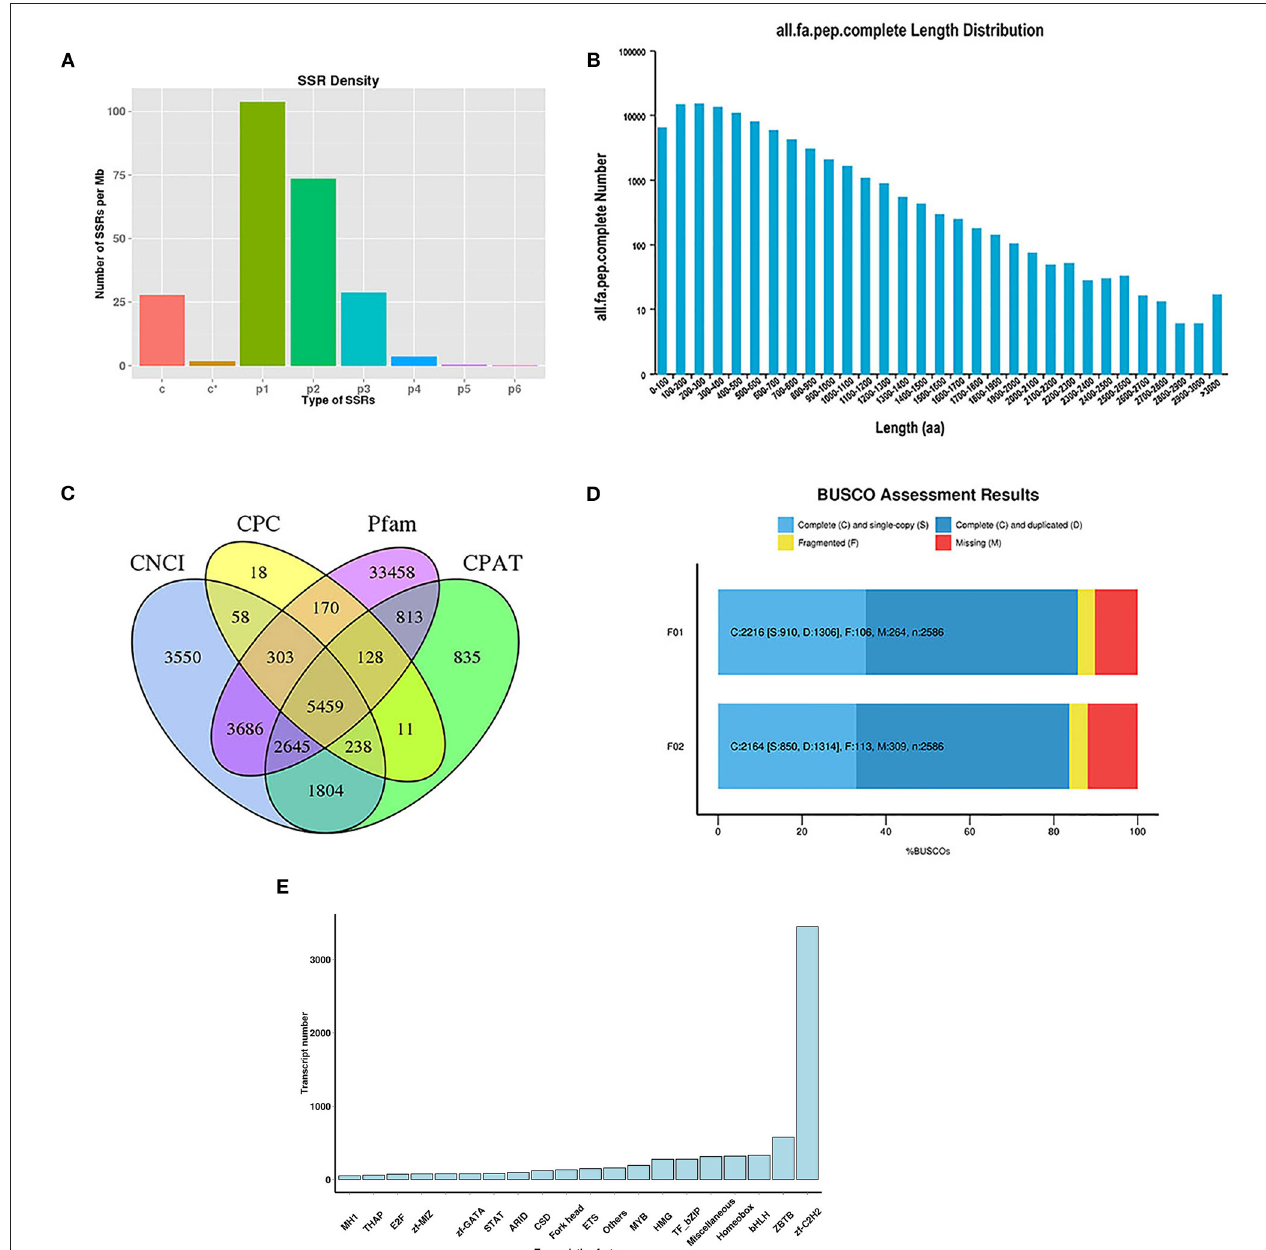
FIGURE 1 | Analysis of SSRs and identification of CDS, TFs, and lncRNAs. (A) The density of different type of SSRs; (B) The length distribution of predicted CDS; (C) Venn diagram for lncRNAs identified by four analysis methods; (D) BUSCO assessment results of the completeness of transcripts generated by CD-HIT; (E) Distribution of TF